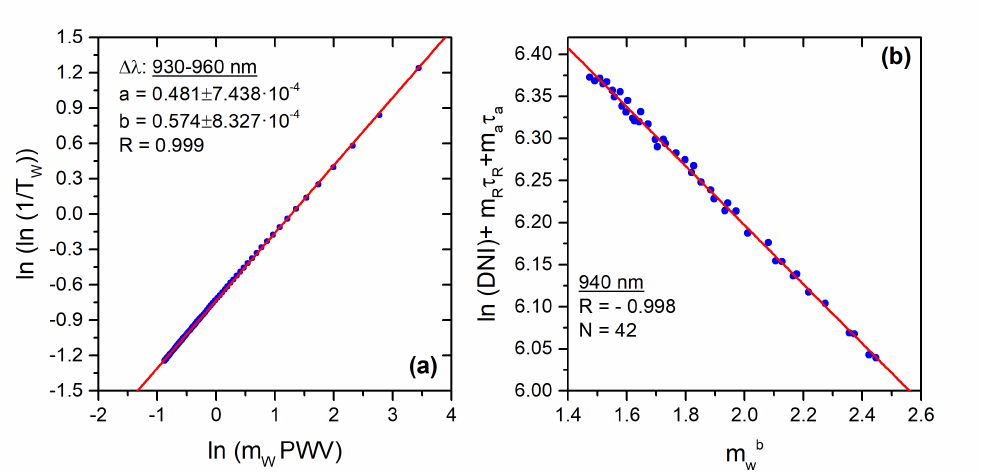
Figure 2. ( a ) Scatterplot of ln ( ln ( 1/ T w ( ∆ λ ))) versus ln ( m w PWV ) between 930 and 960 nm. The fitting parameters are shown in the legend and ( b ) Modified Langley-Plot at 940 nm on 20 May 2019 at IZO. R is the Pearson correlation coefficient and N is the number of data